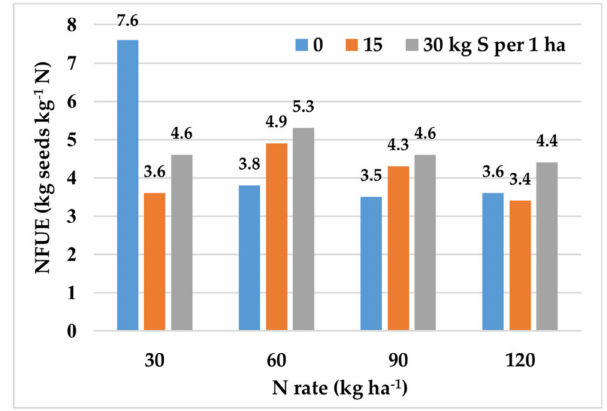
Figure 5. Nitrogen fertilizer use e ffi ciency in treatments with di ff erent S fertilization rates (across years). Straw yield ranged from 1.24–1.80 (2017, 2018) to 3.40 Mg ha